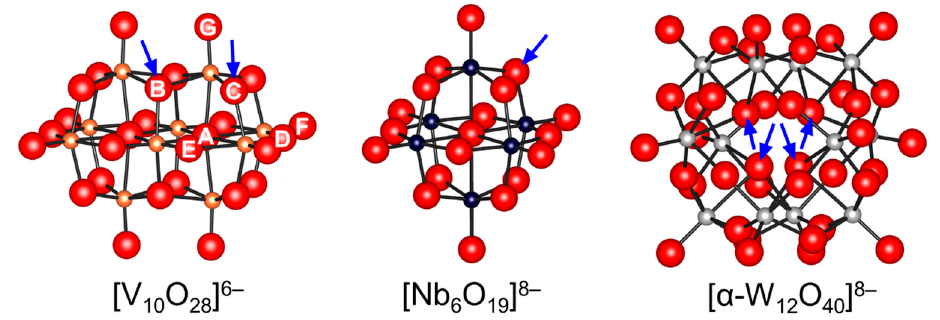
Figure 3. Ball and stick representations of isopolyoxometalates. The arrows indicate the possible protonation sites proposed on the basis of the structure, NMR, and computational analysis [61,64,65,70,71,73,74,78–80].